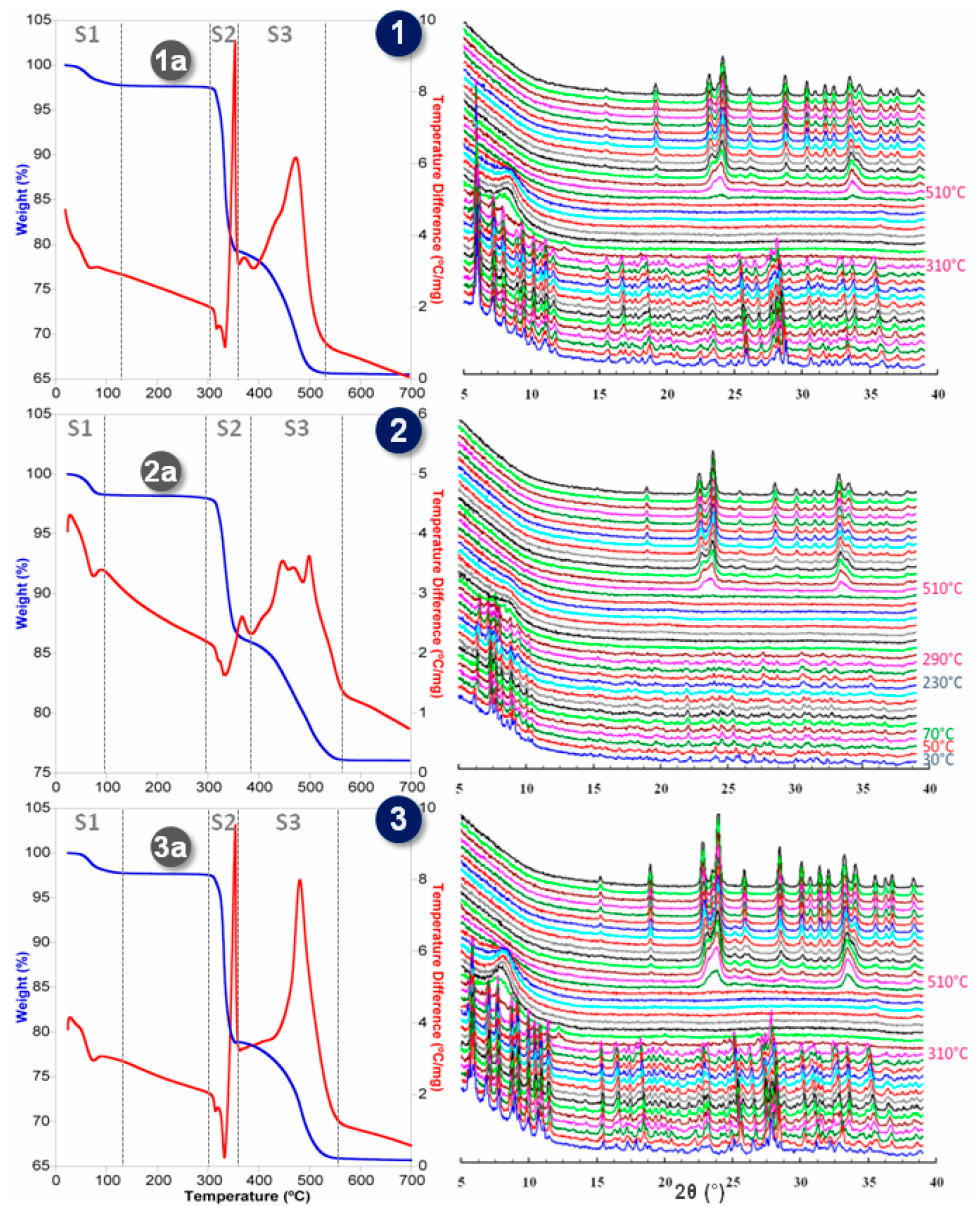
Figure 6. TGA/DTA curves and variable temperature X-ray diffraction patterns for 1 – 3